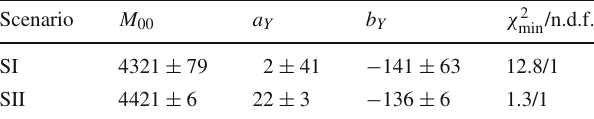
Table 4 Values of the parameters M 00 , a Y , b Y (all in MeV), and χ 2 /n.d.f. resulting from the χ 2 analysis with fixing κ cq = 67 MeV min